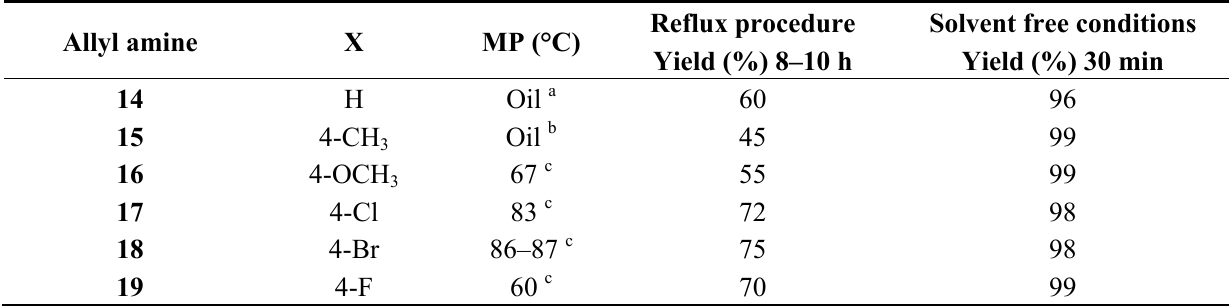
Table 2. Allyl-amine 8 – 12 yields obtained under solvent free conditions and with the reflux method. Allyl amine X MP (°C)